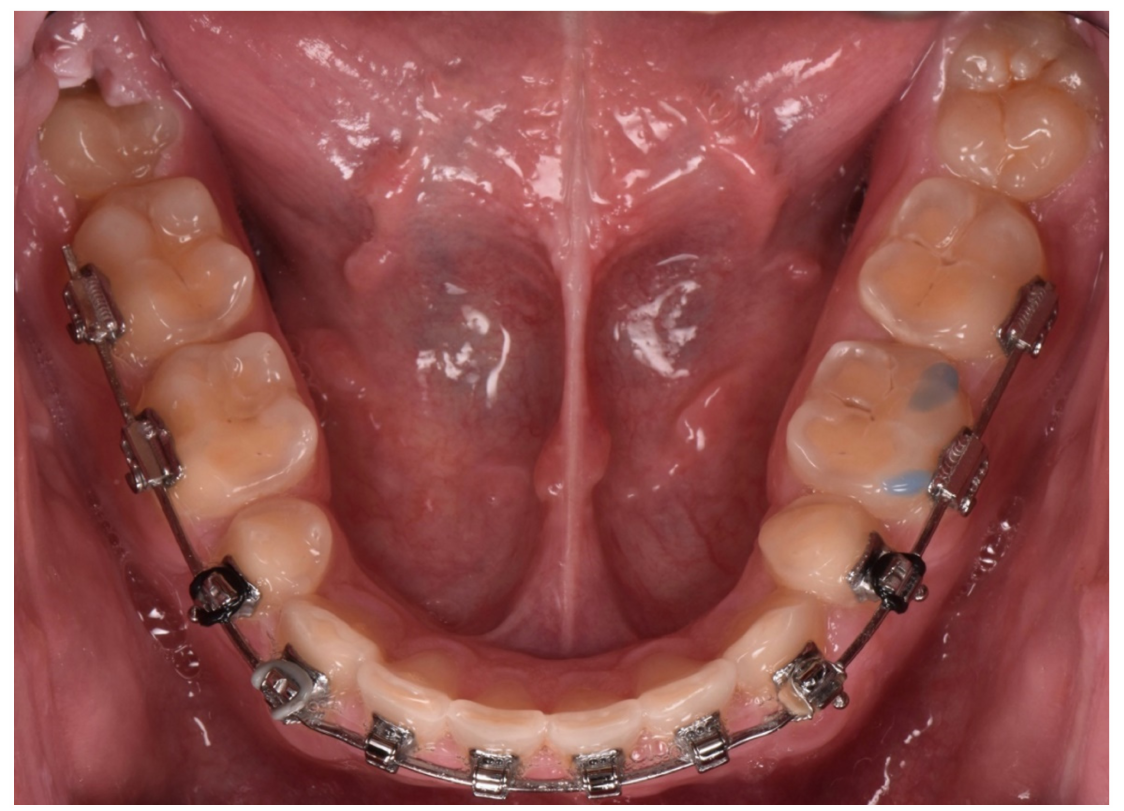
Figure 9. Intraoral occlusal picture (lower